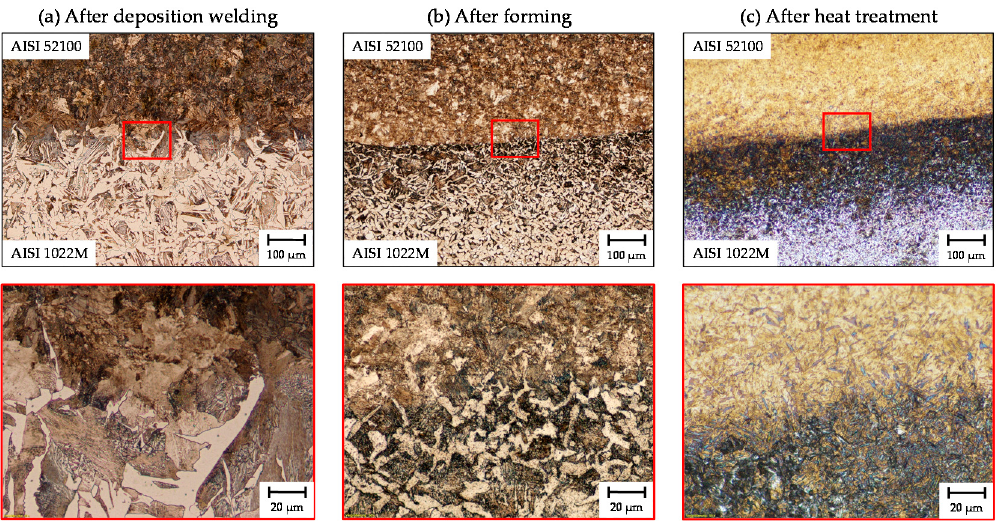
Figure 8. Micrographs of the joining zone: ( a ) After deposition welding; ( b ) after forming; ( c ) after a quenching and tempering heat treatment; ( a , c ) etched with 2% nitric acid solution; ( b ) etched with Beraha I